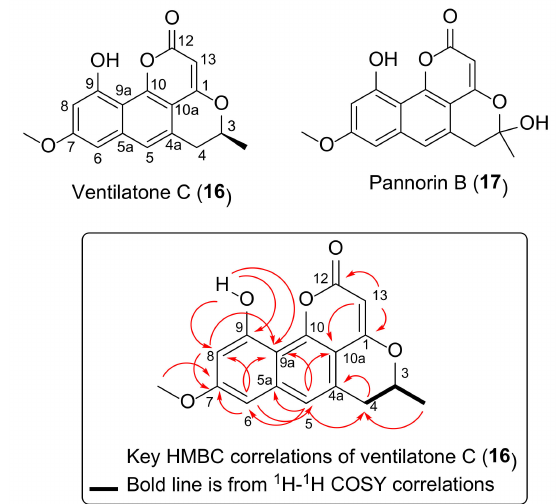
Figure 6. Structures of ventilatone C ( 16 ) and pannorin B ( 17 ), as well as key HMBC and 1 H- 1 H COSY correlations of ventilatone C ( 16 ). HMBC correlations are from proton(s) to carbon. Table 2. 1 H (400 MHz) and 13 C (100 MHz) NMR spectroscopic data for ventilatone C ( 16 ). Ventilatone C Position